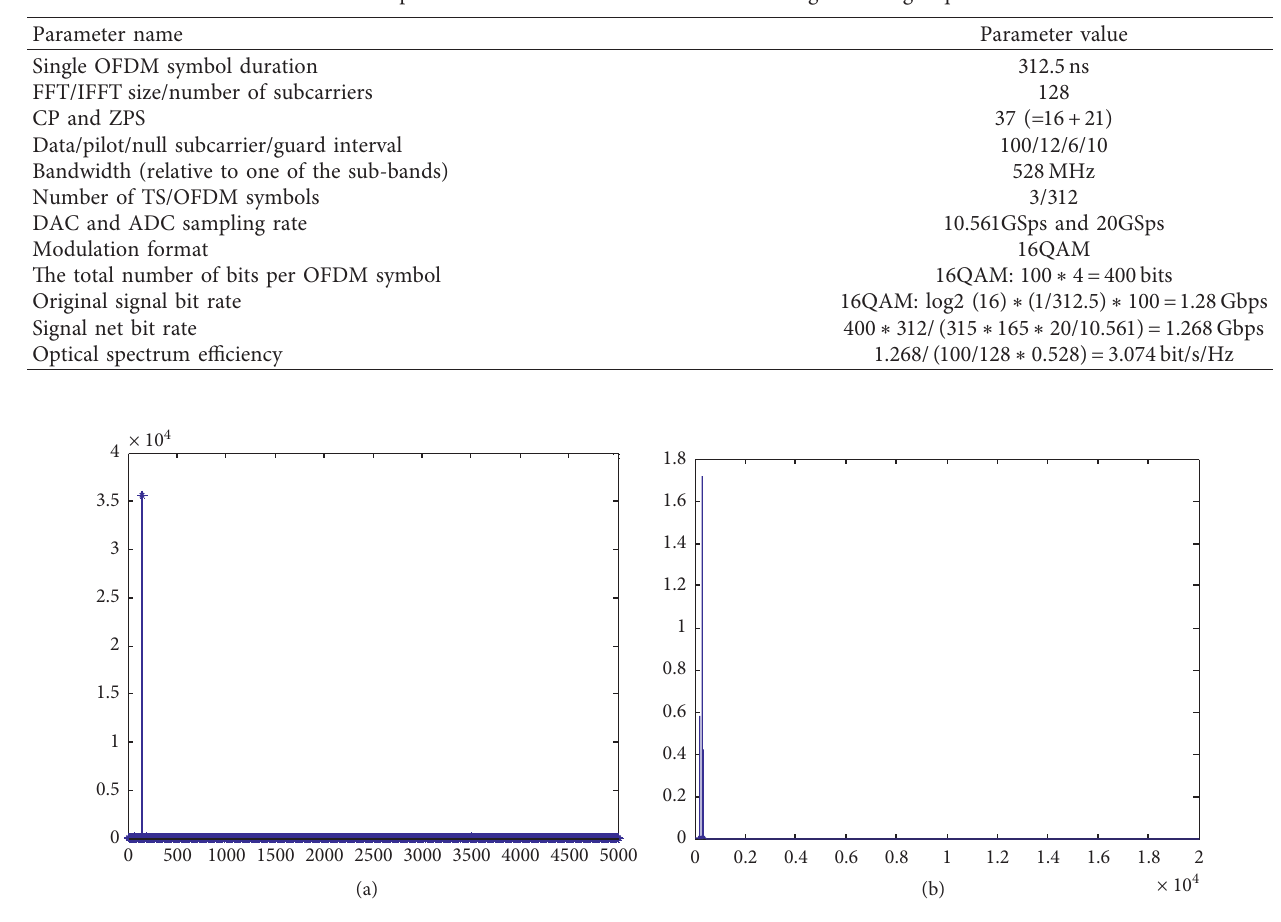
Figure 2: (a) MB-OFDM UWB signal frame timing synchronization metrics based on Golay TS scheme. (b) TS-based timing syn- chronization metrics for MB-OFDM UWB signal frames.